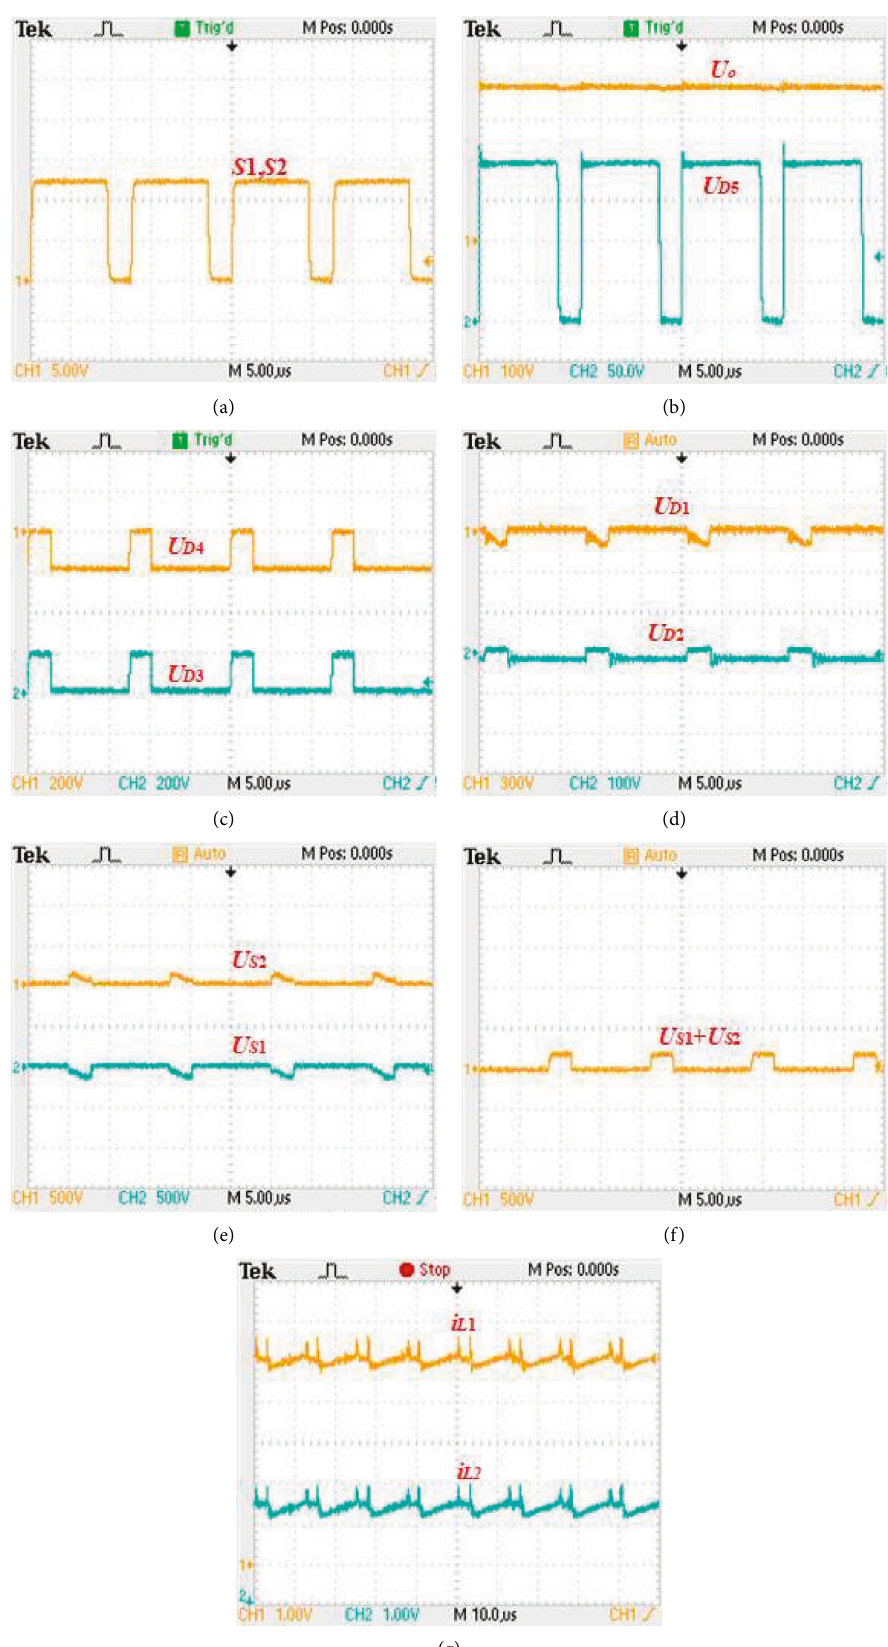
Figure 15: Experimental results when U (f) U S 2 + U S 1 , and (g) currents of L 1 and L 2